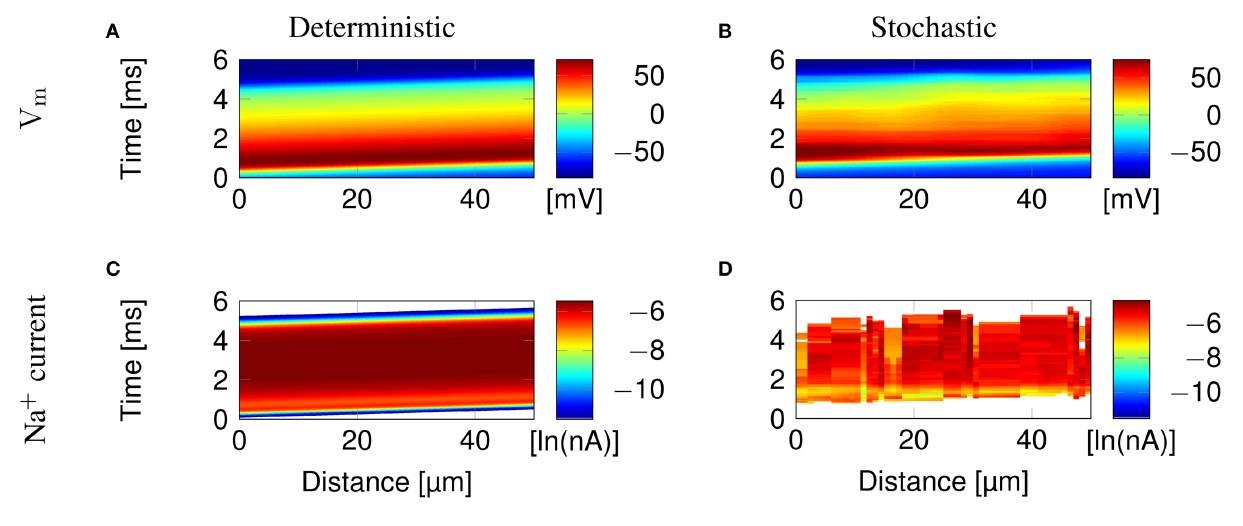
FIGURE 2 | Action potential propagation in a 0.1 µ m diameter C-fiber axon with uniformly distributed Na + channels. (A) The membrane potential and (C) Na + current in a deterministic